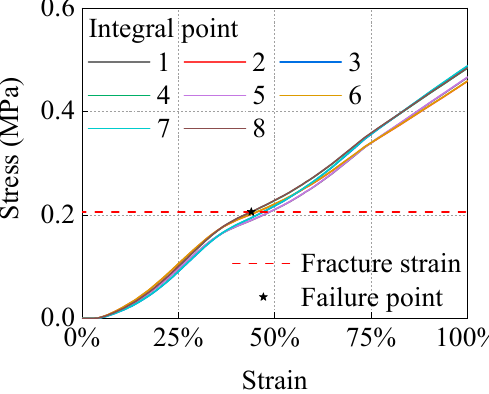
Figure 14. Changes in PEEQ at the integration point of the first failure element with dent depth.